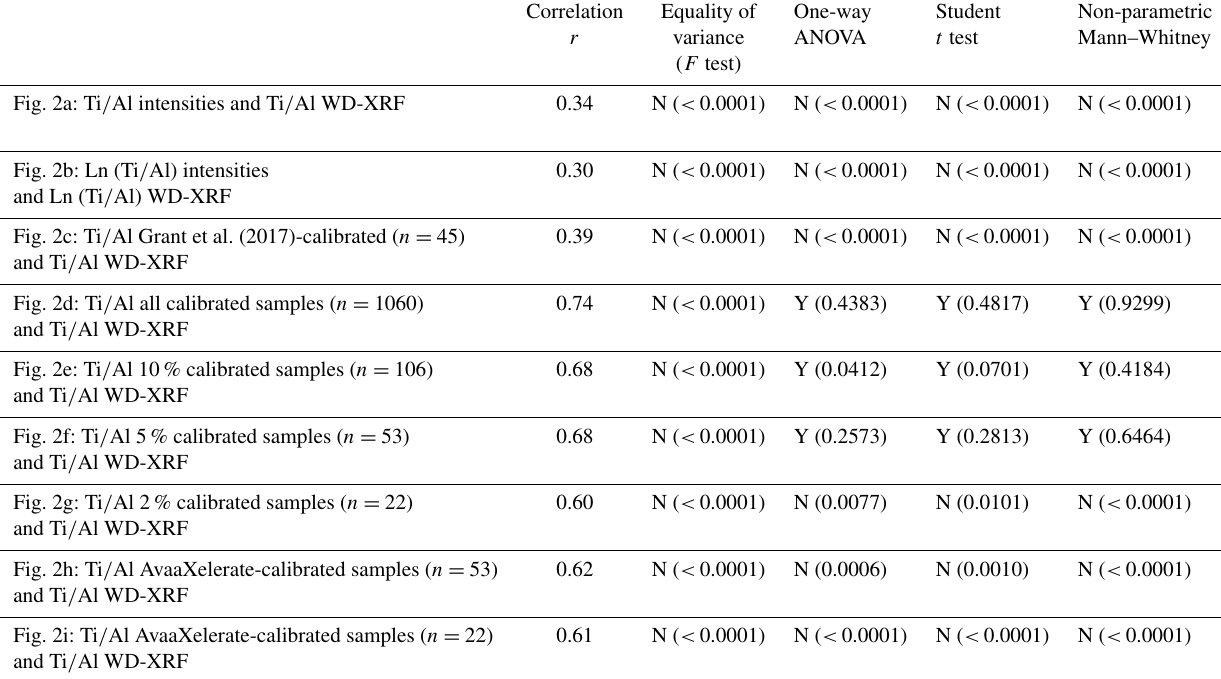
Table 1. Statistical test results between XRF-CS data (uncalibrated and calibrated) and reference data. These data are also shown in Fig. 2. The second column indicates the correlation coefficient r calculated between the datasets. The Y (yes) and N (no) markers in the third to sixth columns indicate whether the null hypotheses of equality of variance (third column) and means (fourth to sixth column) could not (Y) or could (N) be rejected at the α = 0.05 significance level. Hence, a Y indicates that the data are statistically similar. The associated p values are shown between brackets. To correct p values for multiple comparisons, we used the Bonferroni method (i.e., multiply the raw p values, as shown here, by the number of tests).